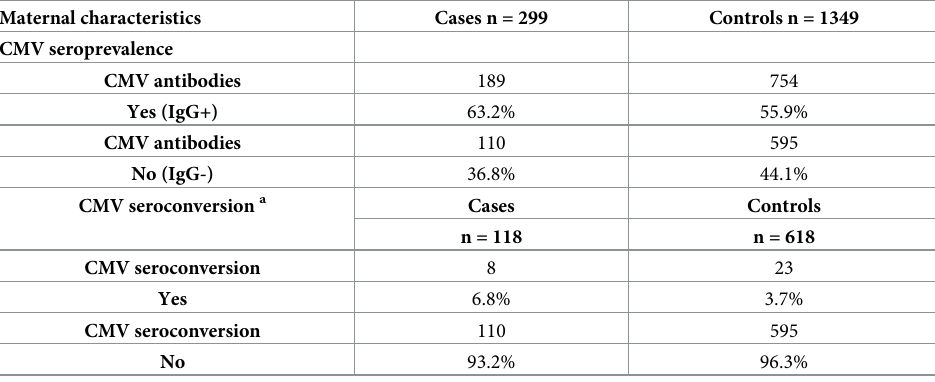
Table 4. Maternal seroprevalence of CMV-IgG antibodies at birth and seroconversion comparing children with or without delayed language development at 3 years of age.